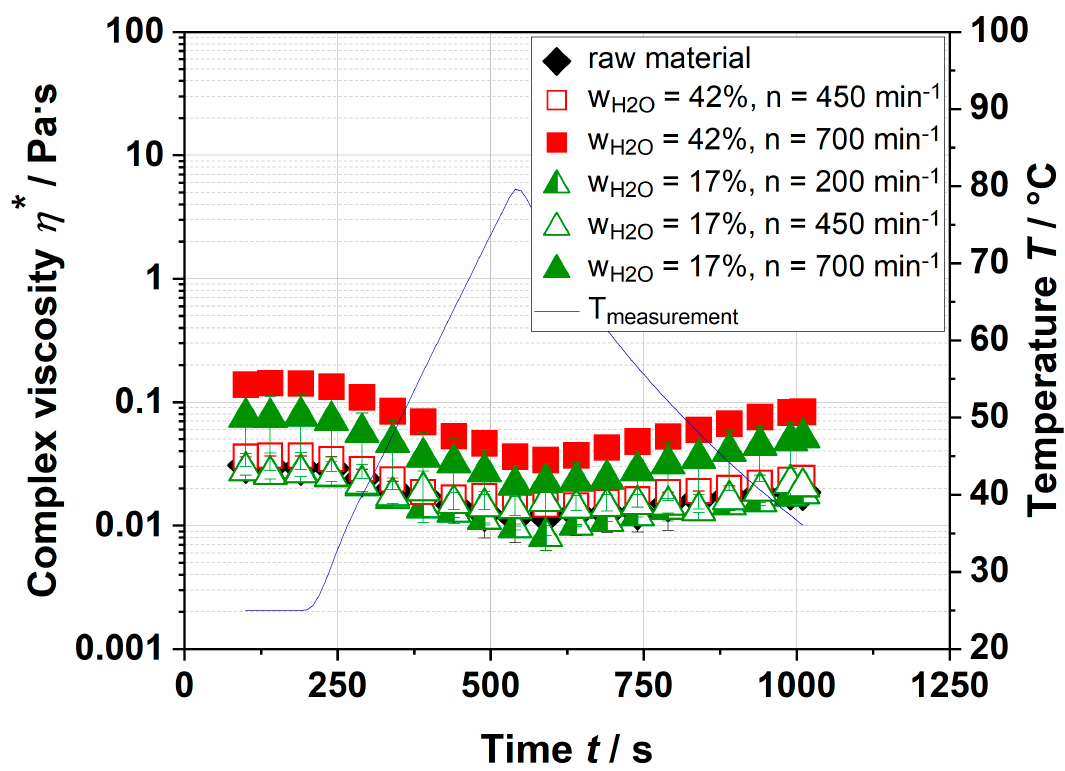
Figure 2. Gelation kinetics of extracted and resolved pectin of raw material and extruded apple pomace for various process parameters. The blue line depicts the temperature ramp of measurements.